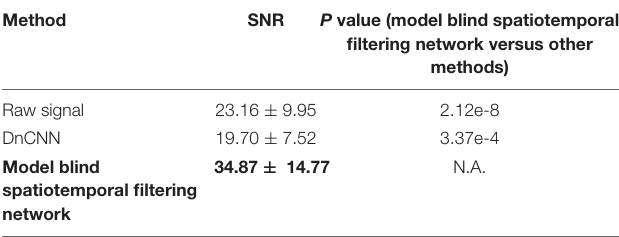
TABLE 2 | Comparison of denoising algorithms for the SNR of Ca 2 +